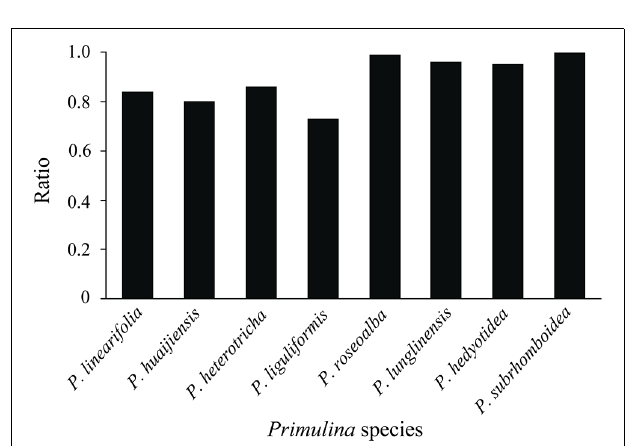
to remove debris and regions drawn to determine peak location and CV (C) , gating procedure completed with FloMax Software (Partec Version 2.80, 2012).